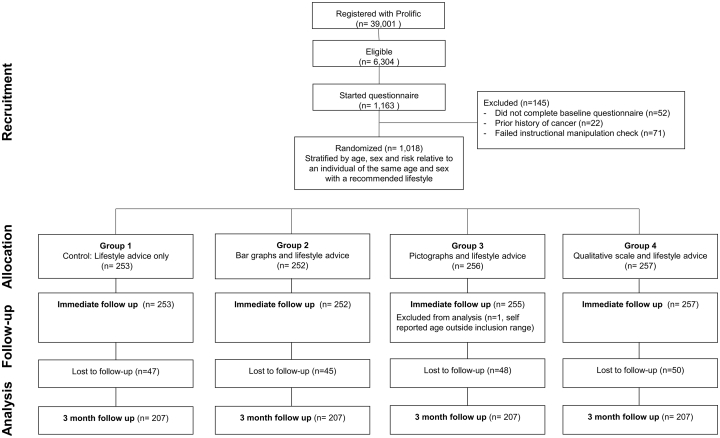
Consort flow diagram.